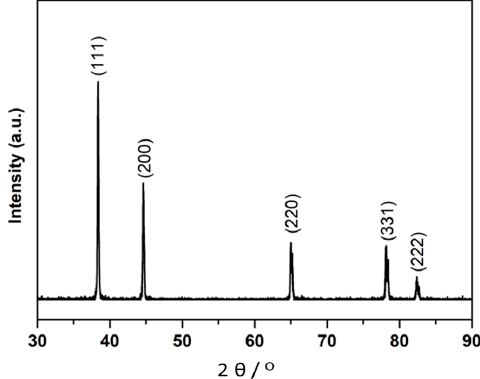
Figure 2. X-ray diffraction (XRD) of plasma-sprayed Al layer.